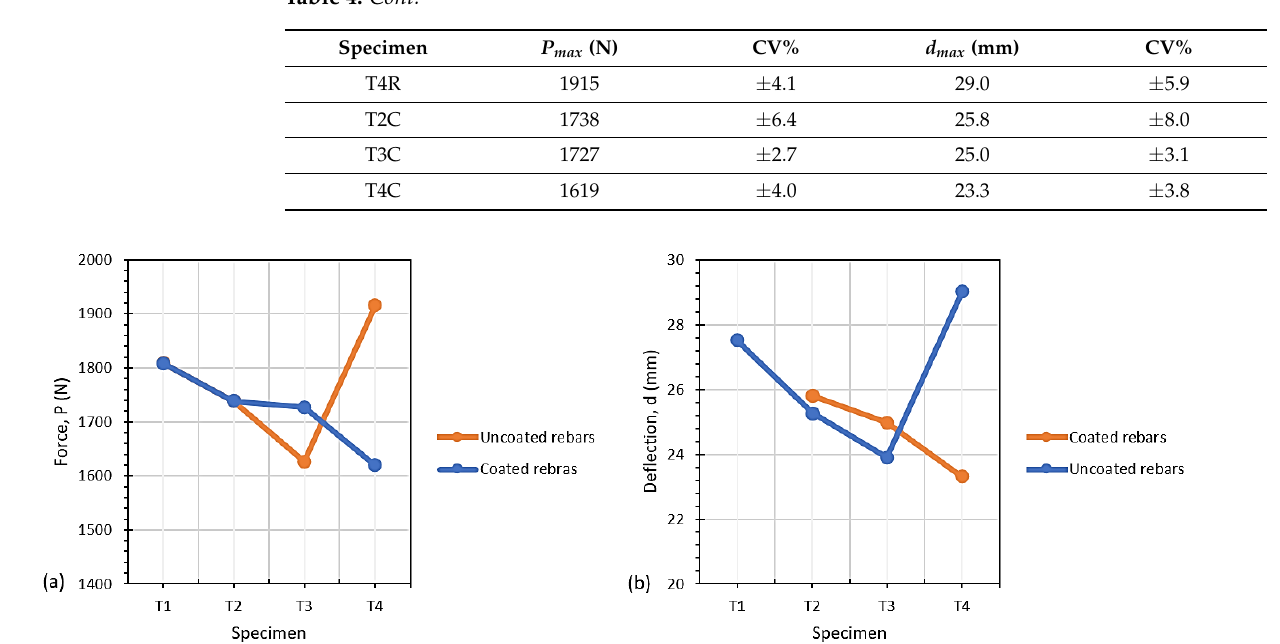
Figure 8. ( a ) Flexural strength of each specimen. ( b ) Maximum flexural deflection of each specimen.